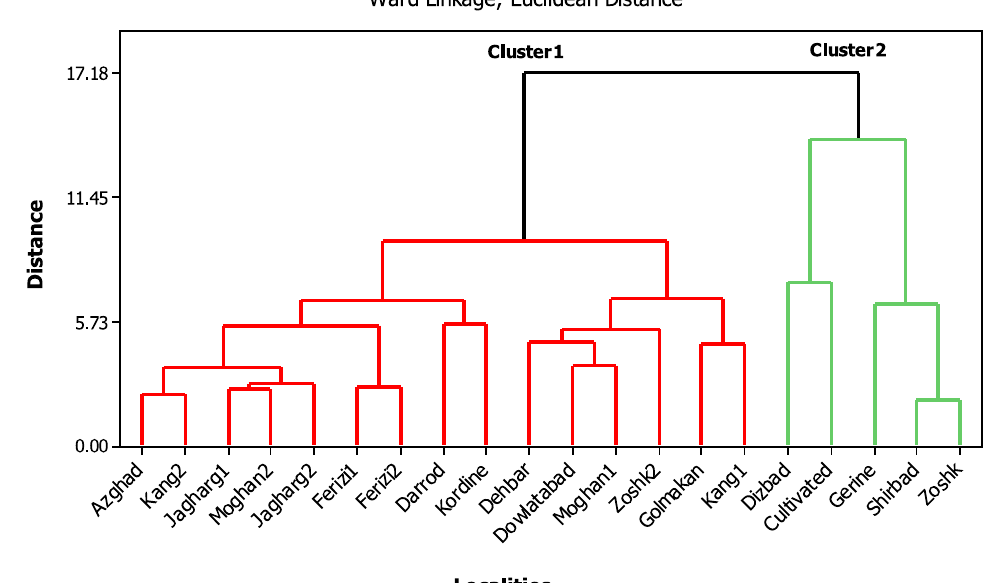
Fig. 1 Picture of Nepeta binaludensis in two habitats Binalud mountain,